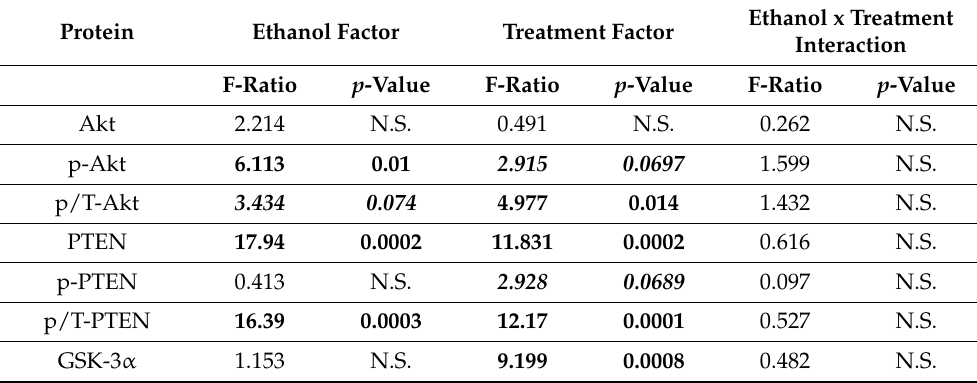
Table 3. Effects of In Vivo Ethanol Exposure and Ex Vivo Interventive Treatments on Akt, PTEN, and GSK-3 Signaling Mediators in Frontal Lobe Slice